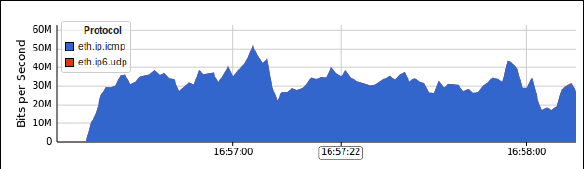
Figure 6. Unprotected DoS Flow Packet